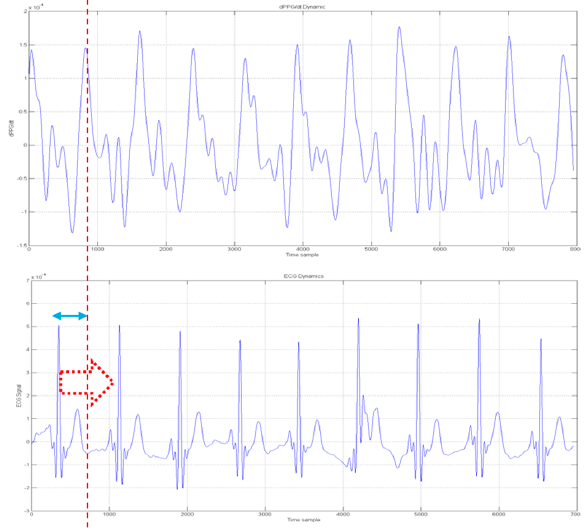
Figure 15. ECG(t k ) (bottom) to dPPG(t (cid:2921) ) dt⁄ (top) analysis.